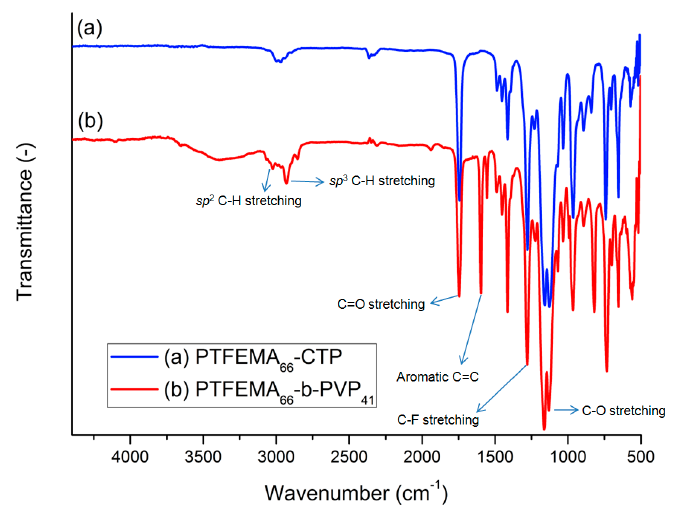
Figure 4. Representative FT-IR spectra for ( a ) PTFEMA 66 -CTP homopolymer and ( b ) PTFEMA 66 - b -PVP 41 block copolymer.